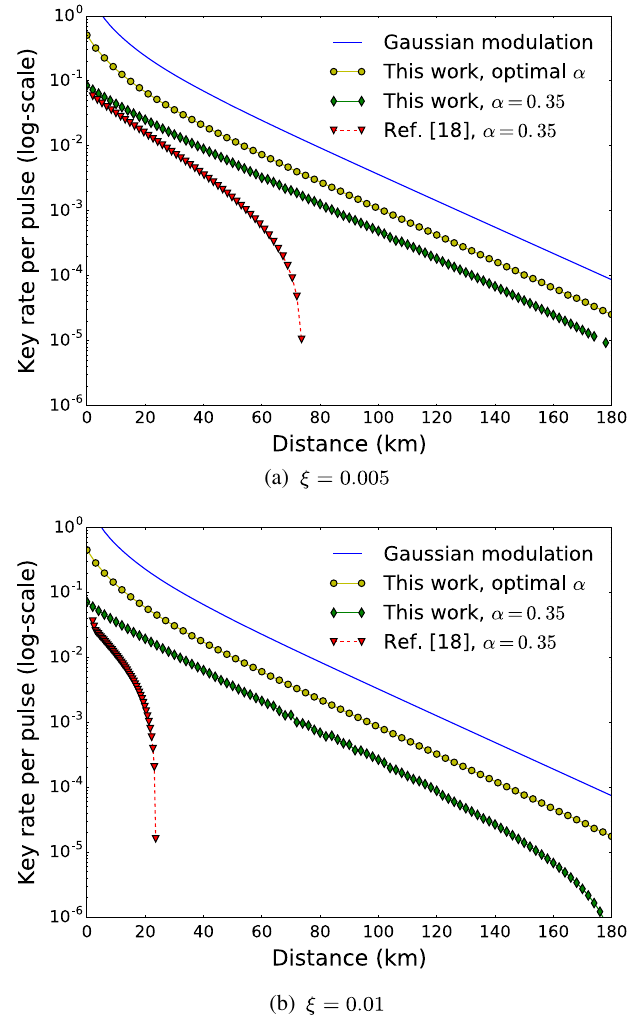
FIG. 9. A comparison of key rates between our work and Ref. [18] for the heterodyne scheme with two different values of excess noise: (a) ξ ¼ 0 . 005 and (b) ξ ¼ 0 . 01 . In each plot, the curve with triangle markers is from Ref. [18] with a fixed (not optimal) coherent state amplitude α ¼ 0 . 35 , and the curve with diamond markers is from this work with the same value of α . The curve with circle markers is also from this work with an optimal value of α for each distance. The curve with no markers is the key rates of a Gaussian-modulated CV QKD protocol [6] with an optimal modulation variance for each distance. All curves use the reconciliation efficiency β ¼ 0 . 95 . fixed choice of the coherent state amplitude α ¼ 0 . 35 for all distances plotted and with two different values of excess noise. As we can see, our security proof approach provides